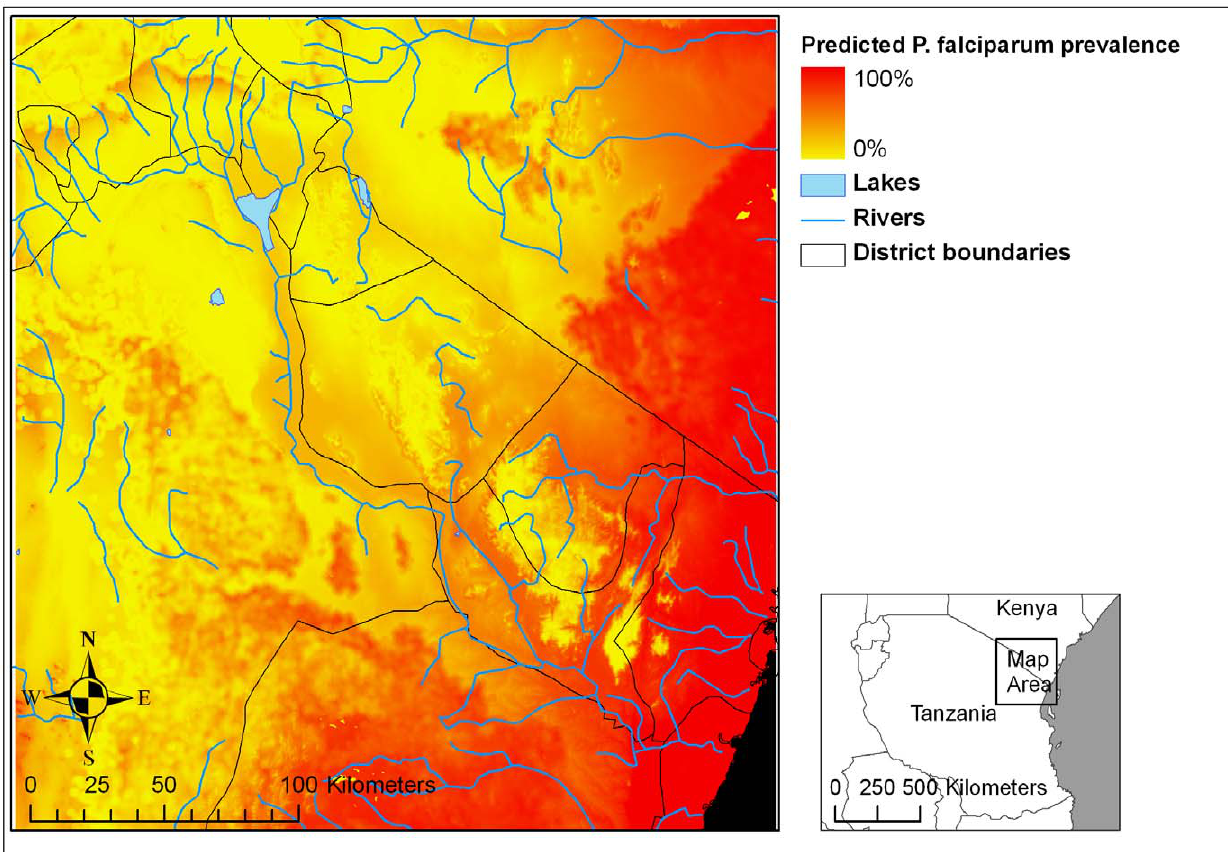
Figure 4. Continuous map of predicted malaria prevalence. Predicted P. falciparum prevalence in children 2 to 9 years old as a function of altitude and vector habitat availability within 1.5 km of grid cells (predicted from niche models) is shown at 30 6 30 metre resolution on a continuous scale.